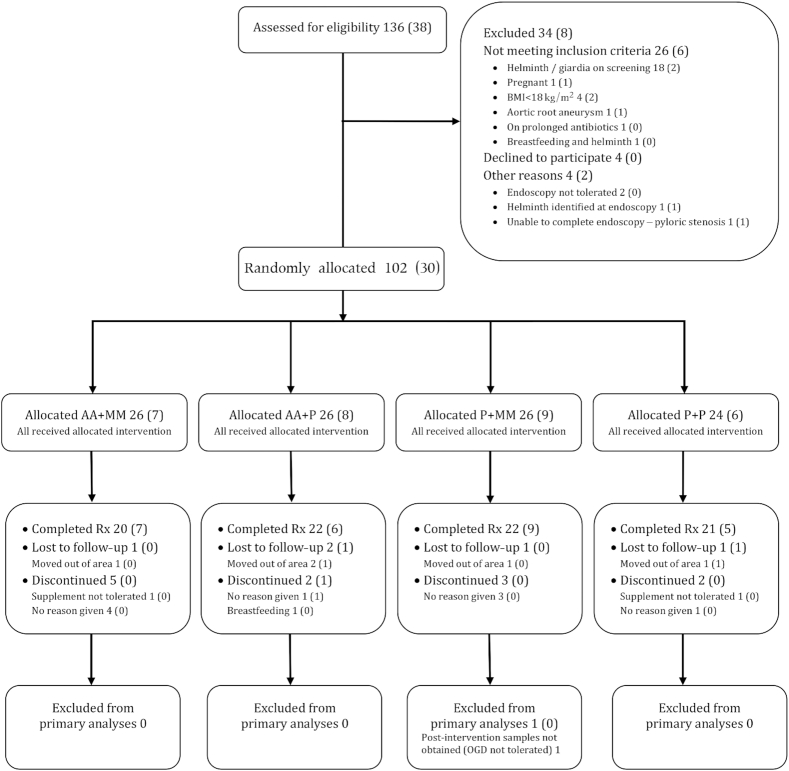
Consolidated Standards of Reporting Trials flow diagram of participants through the trial. Total numbers of participants are given, with the number of HIV-positive participants in parentheses. AA, amino acid; MM, multiple micronutrient; OGD, oesophagogastroduodenoscopy; P, placebo.